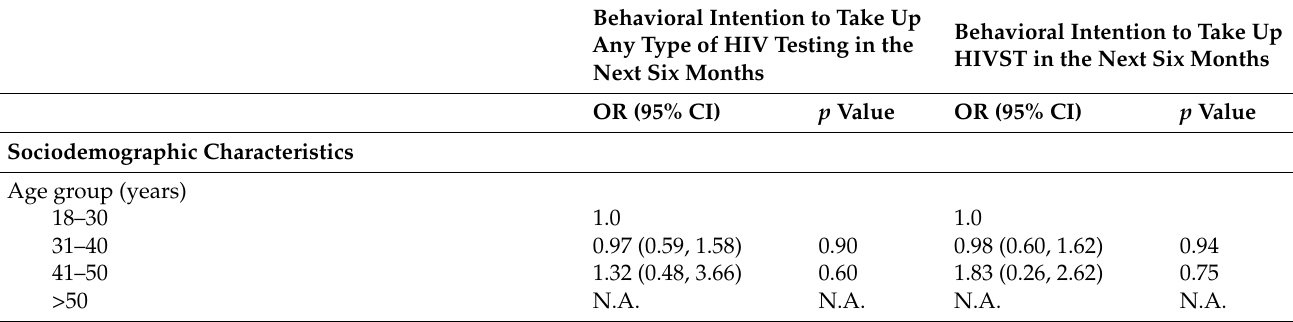
Table 3. Associations between background characteristics and behavioral intention to take up any types of HIV testing/HIVST in the next six months (n =